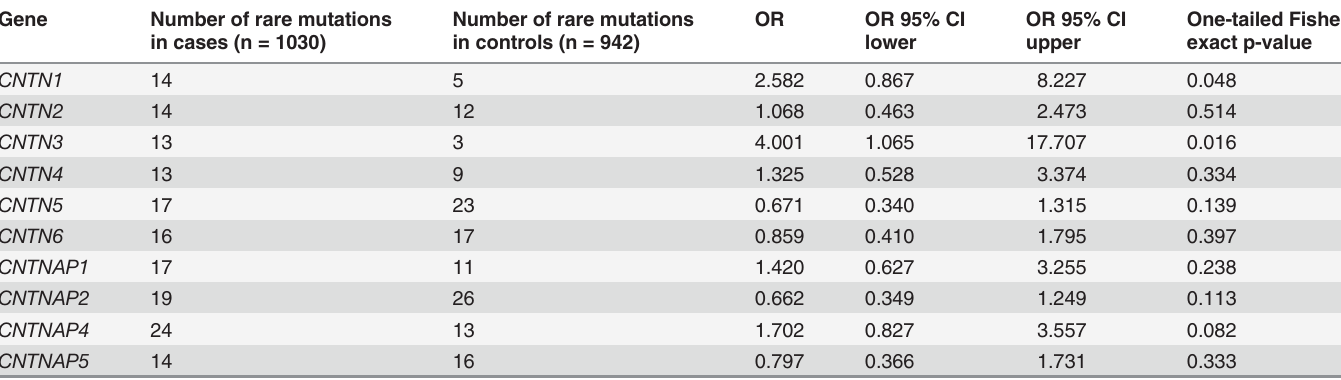
Table 1. Overall rare * variant mutation burden: all genes.